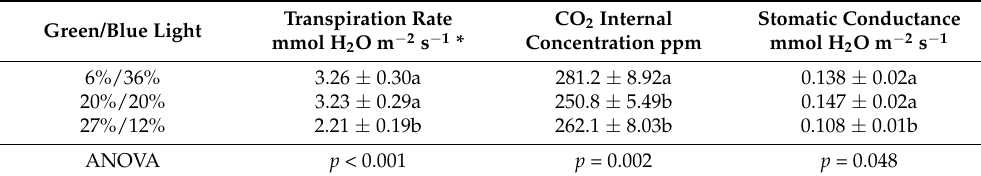
Figure 5. Effect of the green (500–600 nm) and blue (400–500 nm) light balance on photosynthesis rate of strawberry plants grown in an indoor vertical system with LED lighting. ( A ) sampling date 5 July 2002; ( B ) sampling date 26 July 2002. Bars represent the standard error of the mean. Columns with different letters indicate significant differences according to Duncan’s multiple comparison test with p < 0.05. Table 4. Effect of the green (500–600 nm) and blue (400–500 nm) light balance on gas exchange parameters of young mature leaves of strawberry plants grown in an indoor vertical system with LED lighting. Sampling date 5 July 2021.